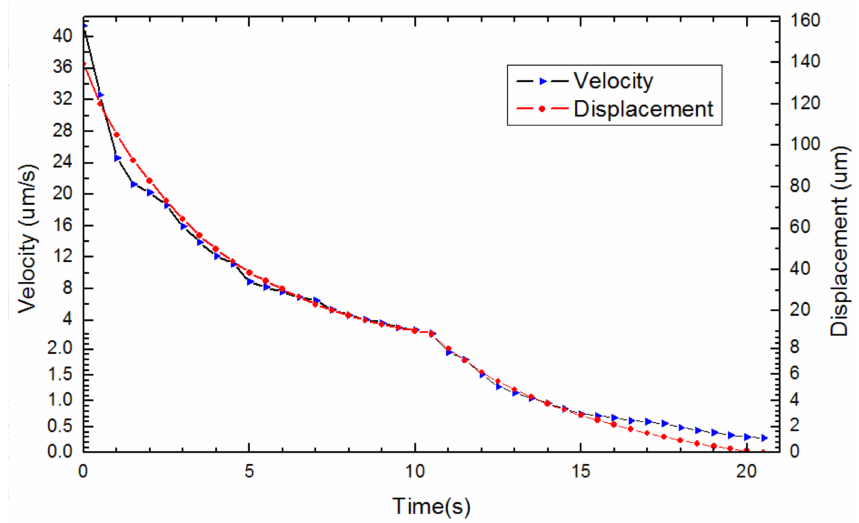
Figure 9. Characterization of automated centering procedure vision-based tracking for the X-axis. Velocity vs. time (black line), displacement vs. time (red